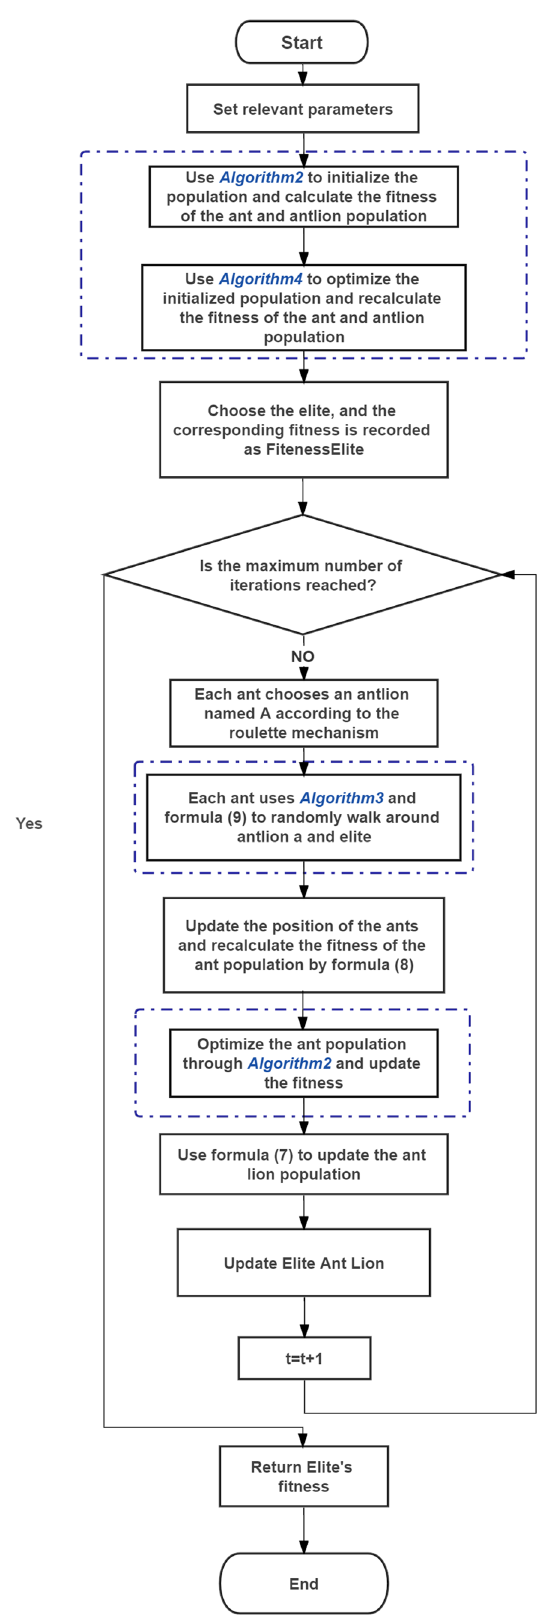
Fig. 2 Flow chart of CAA